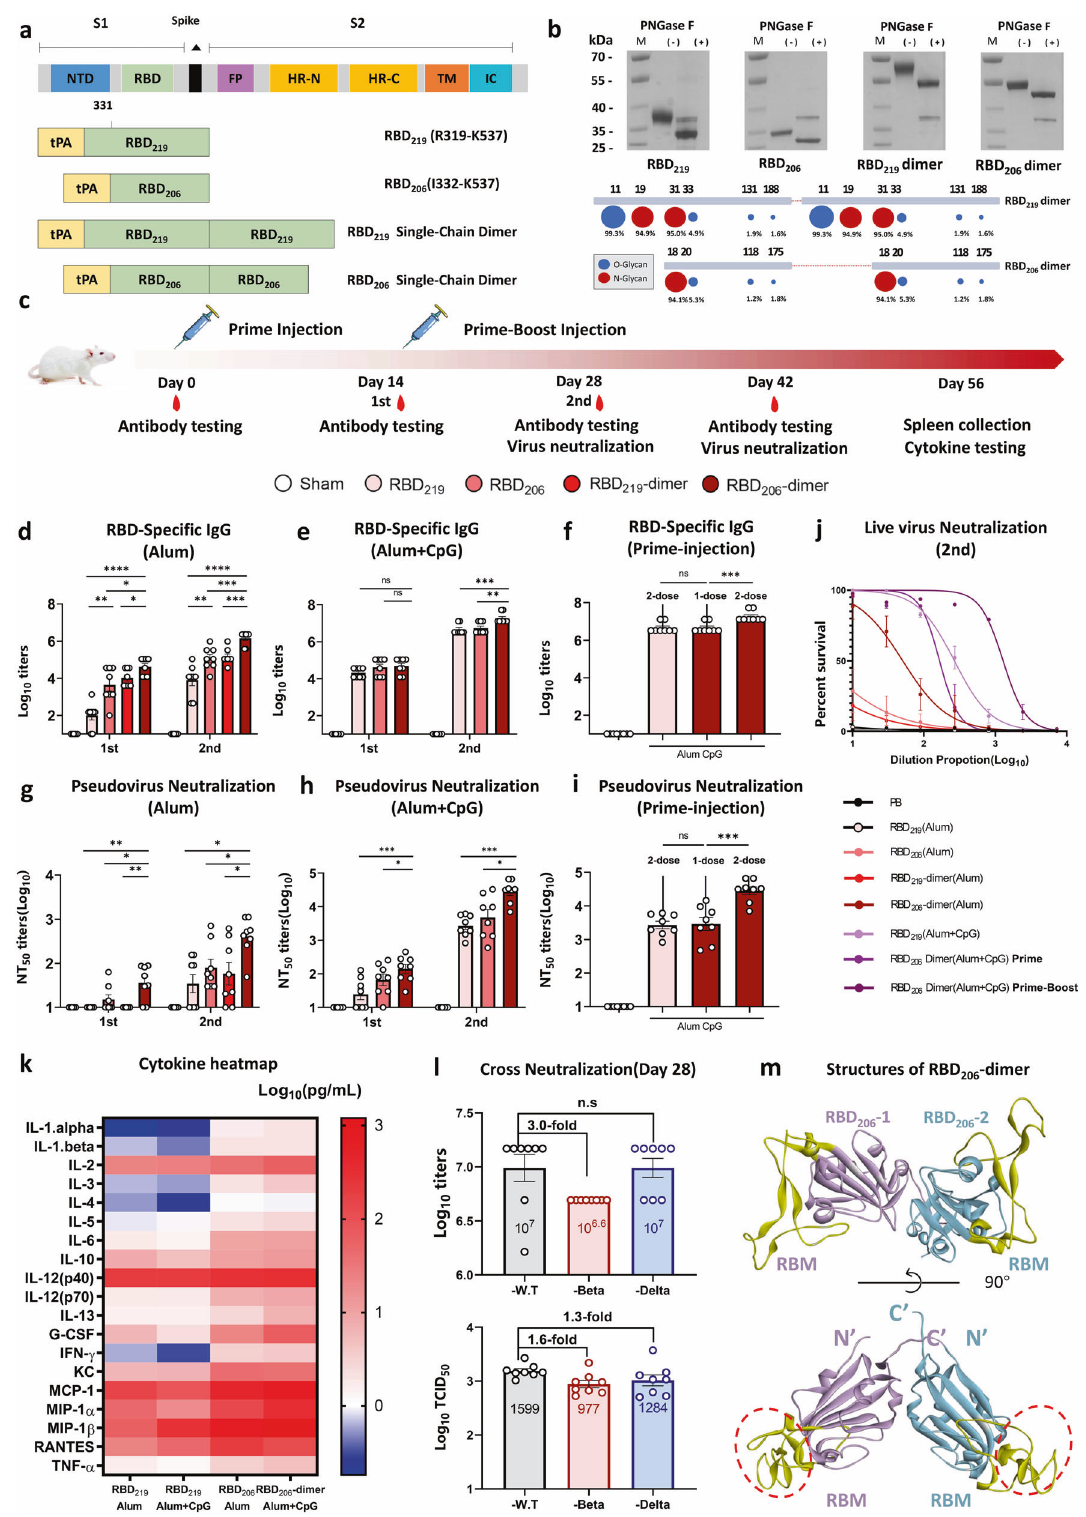
observed in IgG subtypes (Fig. S3). We veri fi ed a Th1-dominant response as displayed by IgG1 subtype-speci fi c titers (~10 5 ) induced by RBD 206 -dimer with alum, which was slightly higher than that induced by RBD 219 . CpG was shown to boost the IgG2a titers. We found that RBD 206 -dimer elicited higher cytokine levels, Signal Transduction and Targeted Therapy